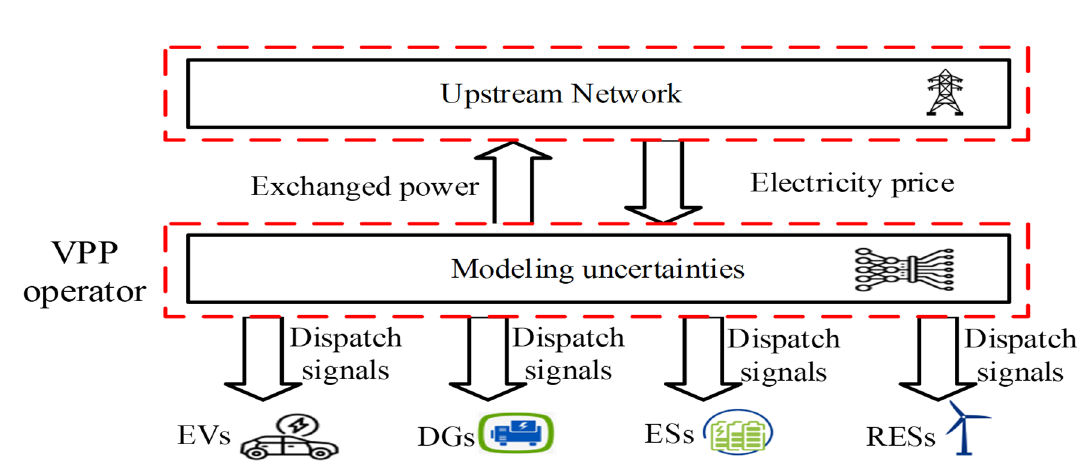
Figure 1. Structure of the proposed method.